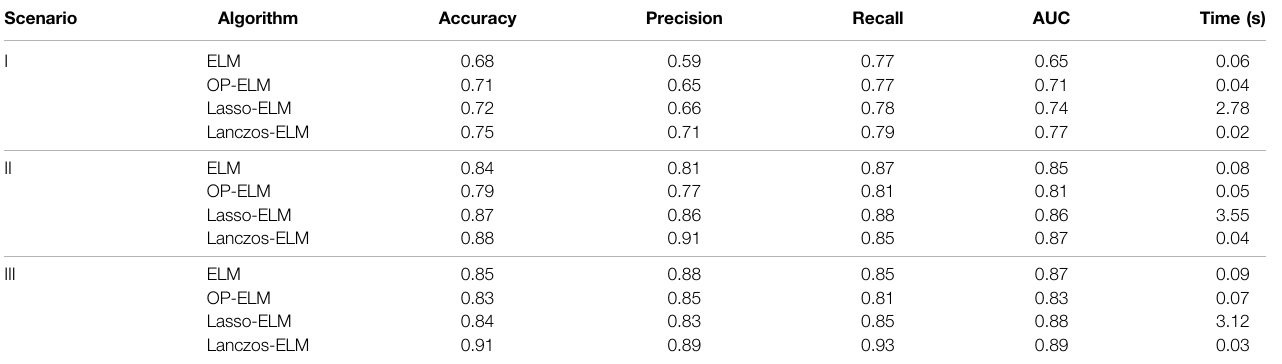
Figure 5B . The in fl ection point, building height, and building